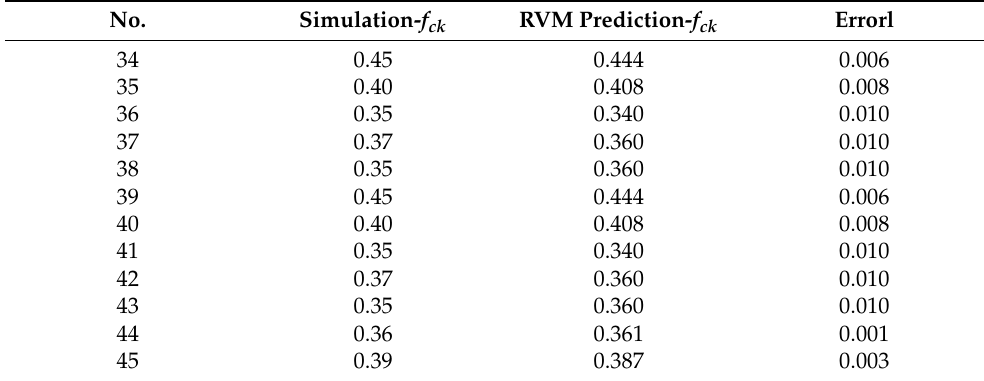
Table 5. Predictive value and simulation value.